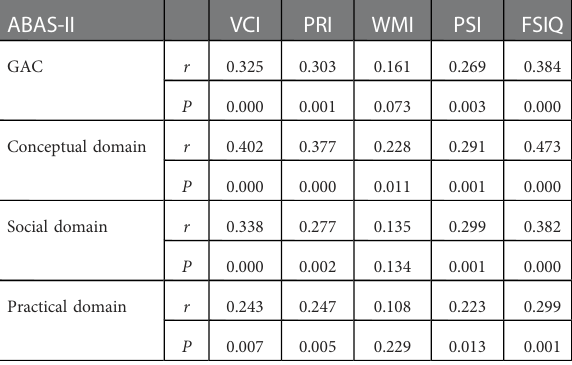
TABLE 4 Pearson correlations between intelligence pro fi les and adaptive behaviors in the HFASD